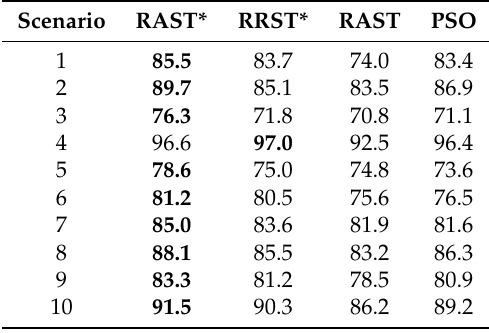
Table 3. Information gathering of RAST*, RRST*, RAST, and PSO over ten randomly selected scientific interest areas with 50 × 35 grids. The maximum information gathering for each scenario has been highlighted in